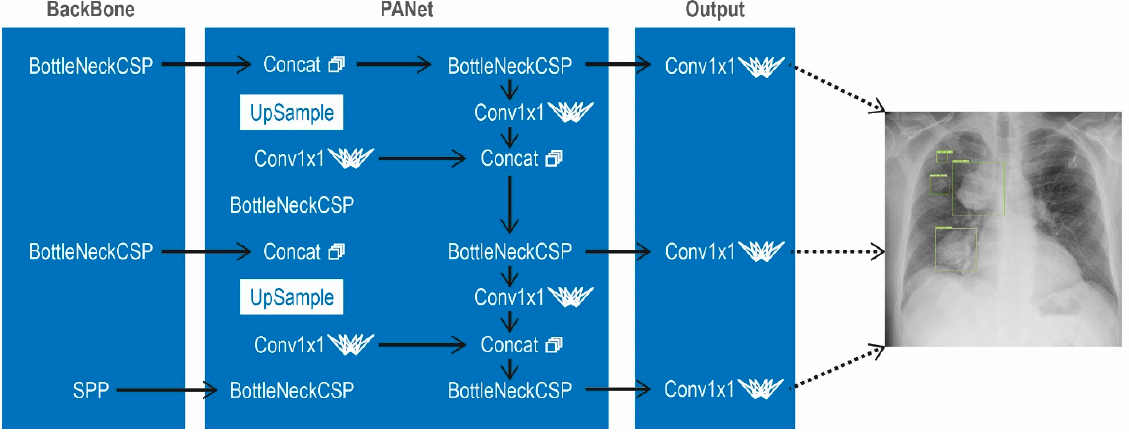
Figure 2. Scheme of the YOLOv5 Architecture as Convolutional Neural Network (CNN). Main parts include the BackBone, Neck and Head. In the BackBone, CSPNet is used in order to extract features from the images which are used as input images. The Neck is used for the creation of pyramid feature. It helps the module on scaling factor of detected objects which are of the same nature but different scales. The technique which is used for creation of pyramid features is PANet. The main function of the head module is to apply anchor of different sizes on those features which are generated in the previous layers with value of probability as well as bounding box with score. SPP stands for Spatial Pyramid Pooling, Concat stands for concatenation.